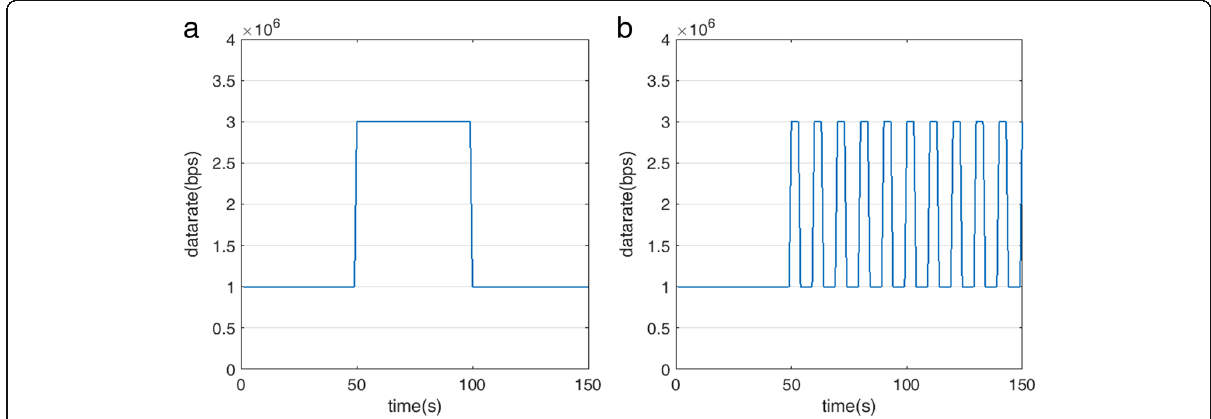
Fig. 3 Training data extraction environment. a Long-term changes in point-to-point link network. b Periodic short-term changes in point-to-point link